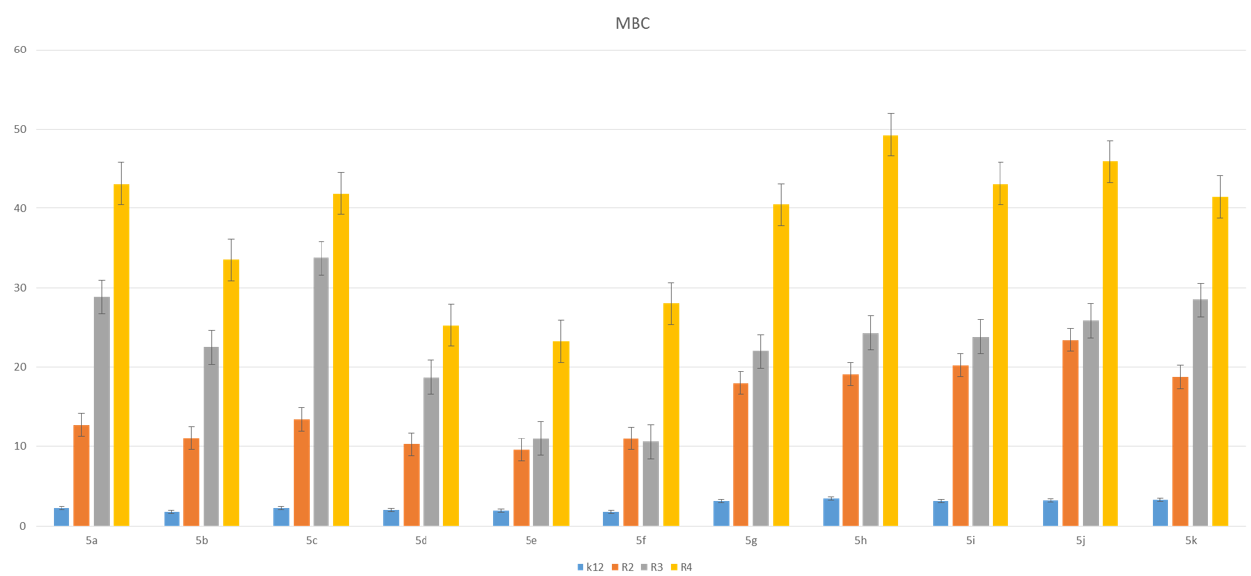
Figure 4. MBC of the pyridine derivatives in model bacterial strains. The x -axis 11-compounds were used sequentially. The y -axis shows the MBC value in µg/mL −1 .